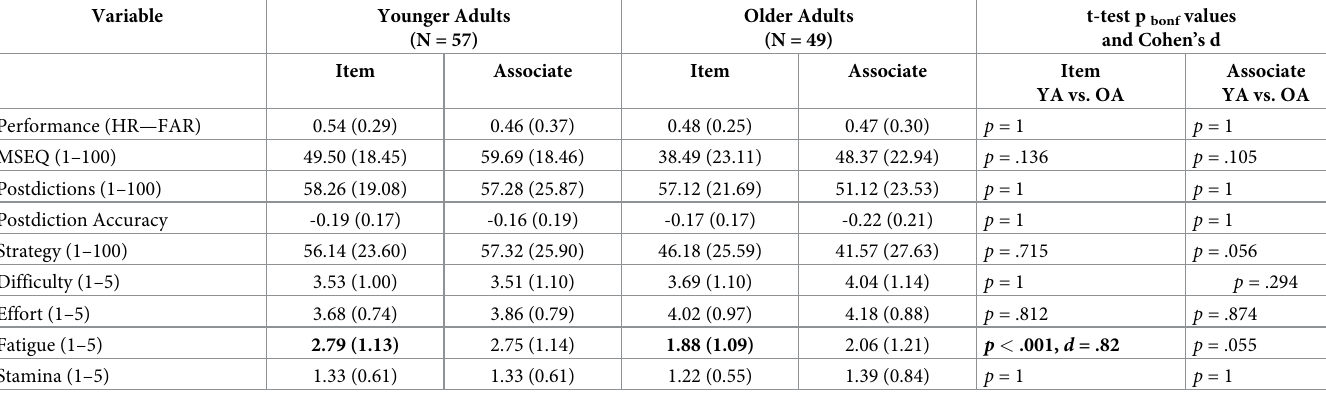
Fig 1. Recognition performance (hit rate minus false alarm rate) by age, stimulus type, and test type. https://doi.org/10.1371/journal.pone.0220526.g001 Table 2. Performance and metacognition means and standard deviations by age and test